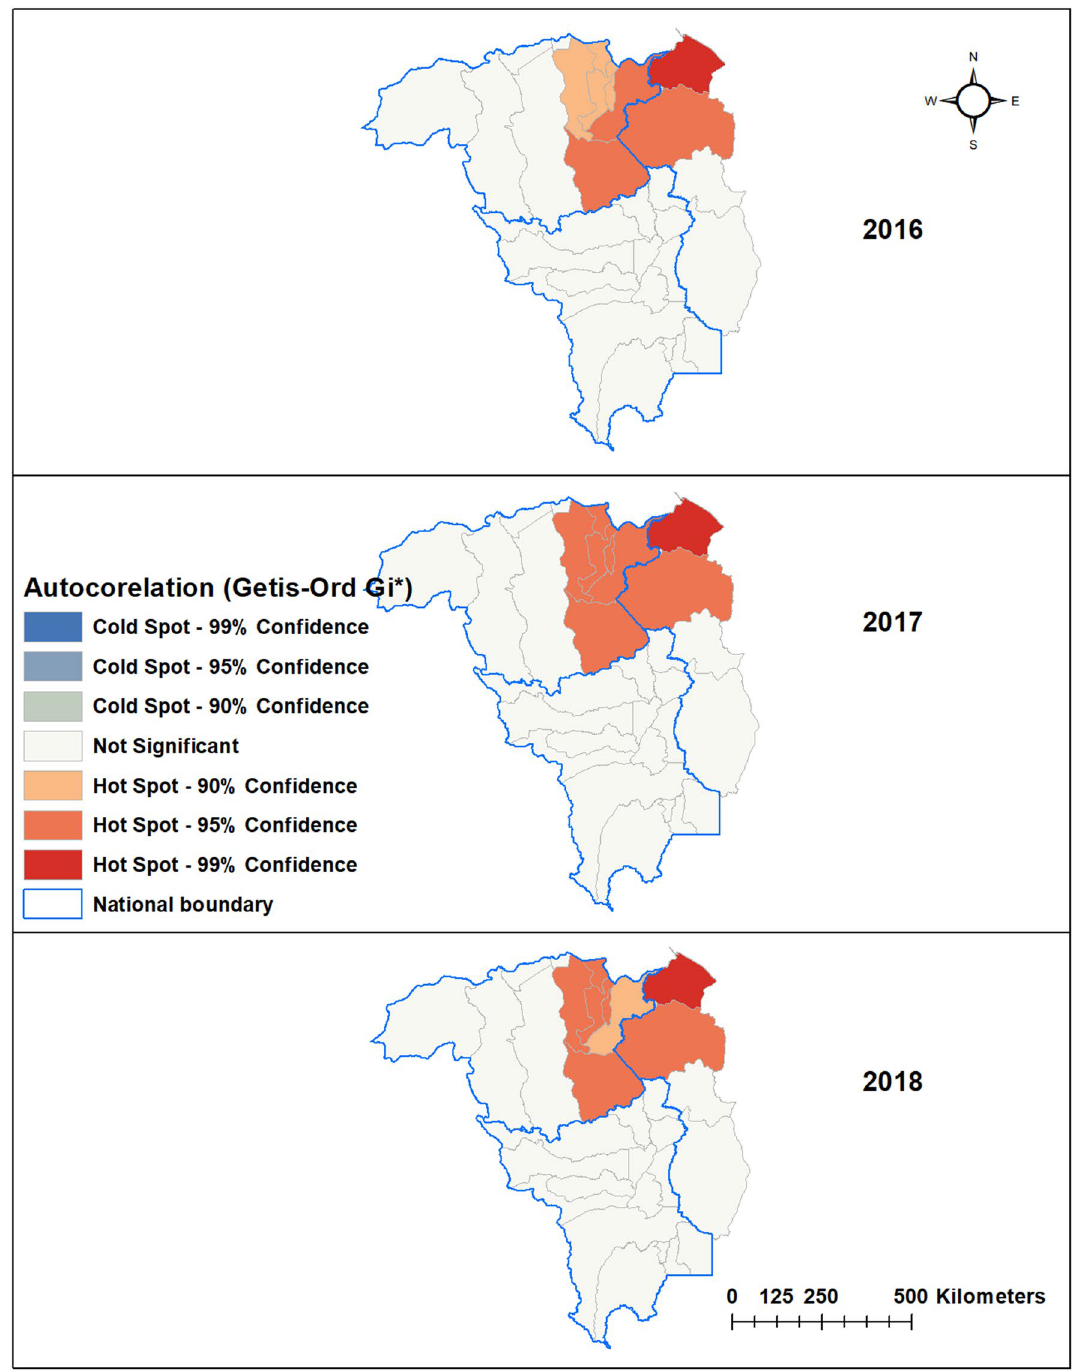
Figure 3. Hot spots (Getis-Ord Gi*) of Plasmodium falciparum